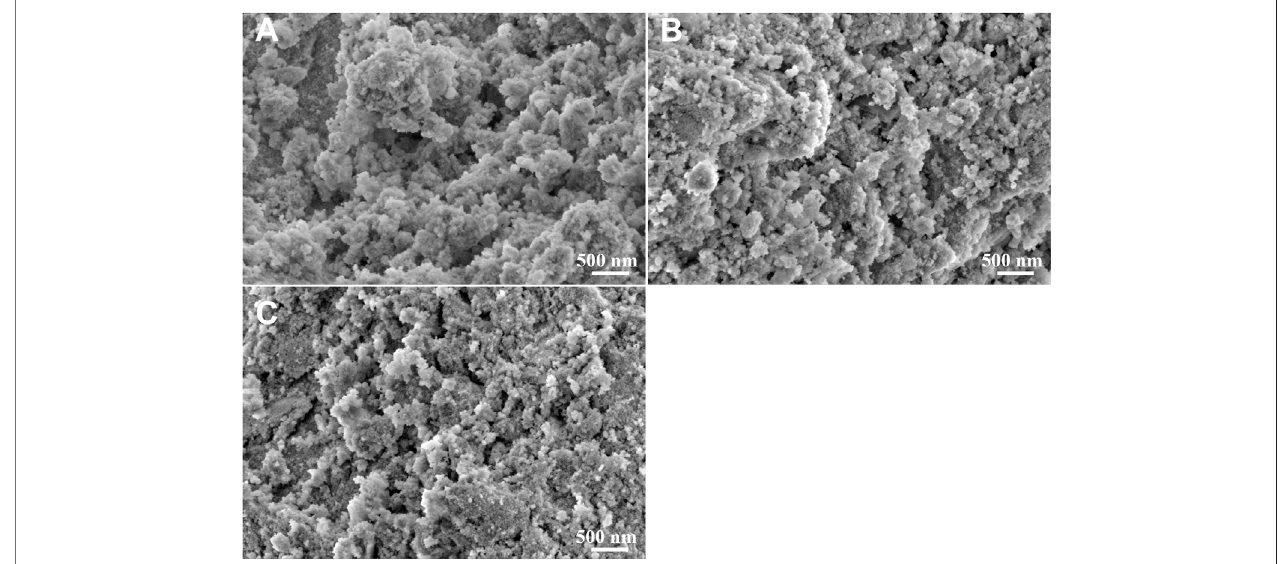
FIGURE9| SEMimagesof fi ltration residues obtained atLa/Fmolar ratiosof1:3.00withdifferentdosesofNa 2 SiO 3 . (A) 0.50 g L − 1 , (B) 0.75 g L − 1 ,( C )1.00 g L − 1 .